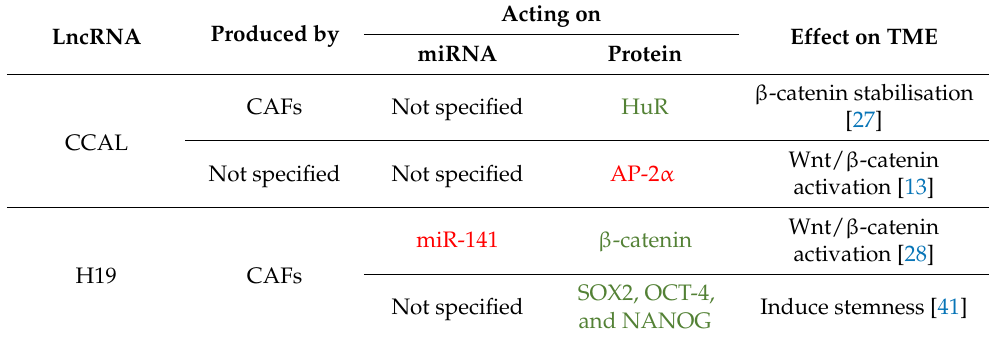
Table 2. The most important lncRNA–miRNA axes impacting TME and drug resistance in